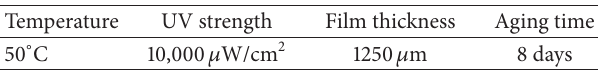
Figure 2: UV simulation machine with asphalt mixture in it. Table 3: UV aging test conditions for bitumen